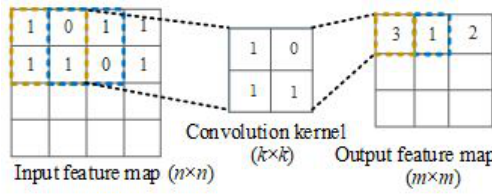
Fig. 1. Principle diagram of convolution process